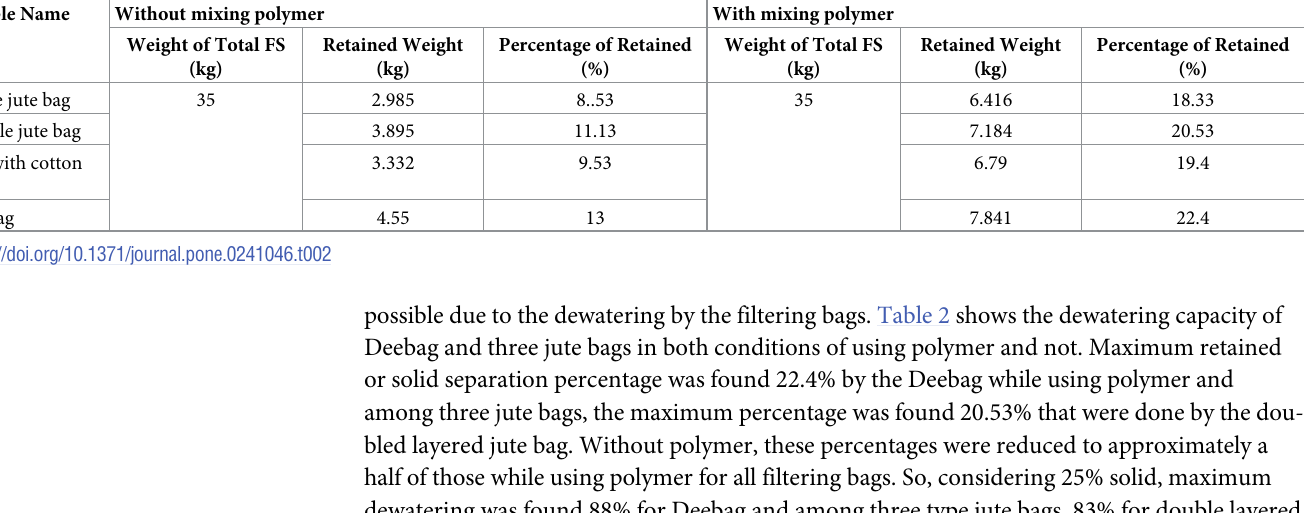
S1 Table. Concentration and removal percentages of BOD5.